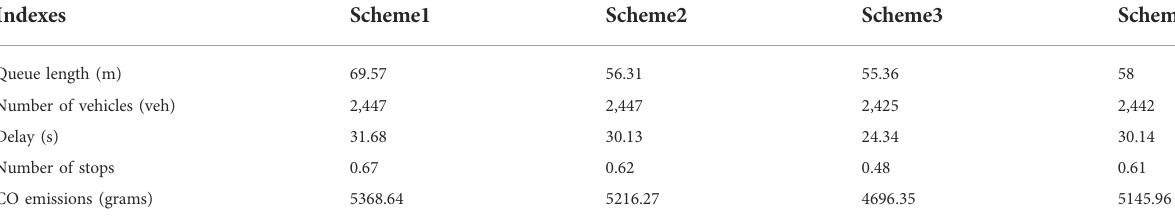
TABLE 3 Simulation results of four